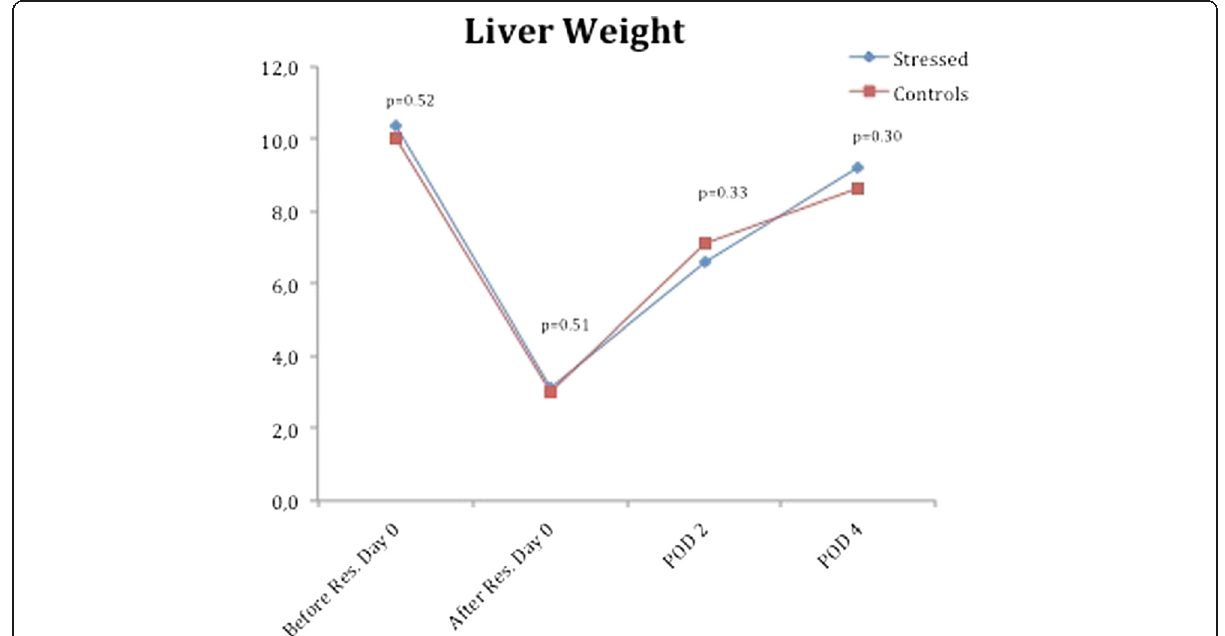
Fig. 4 Liver weight. Mean liver weight for each group of animals. The blue line marks the treatment group and the red line marks the control